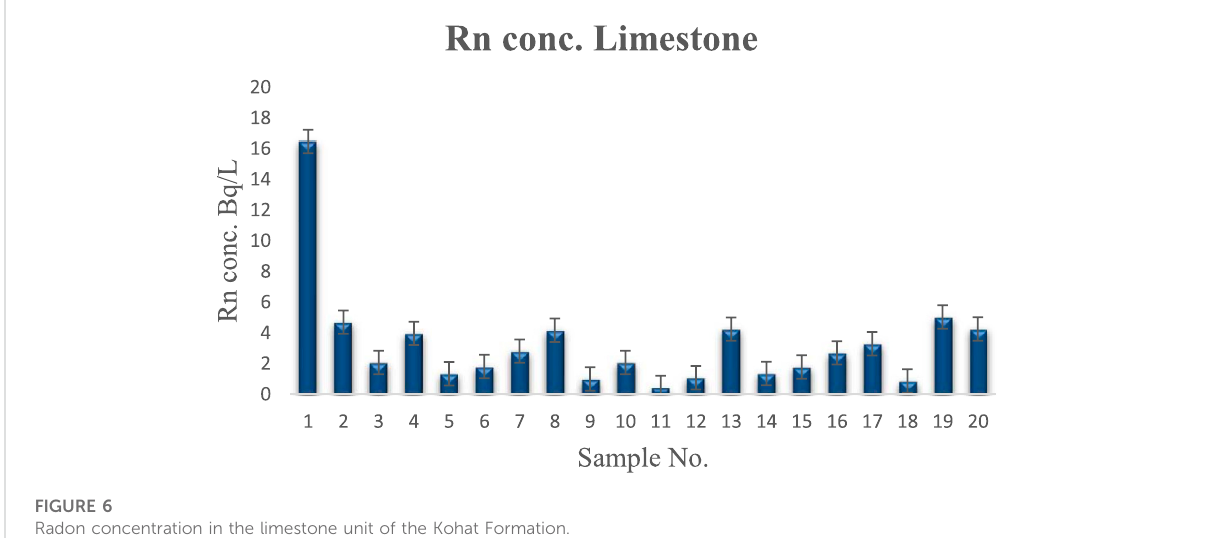
FIGURE 6 Radon concentration in the limestone unit of the Kohat